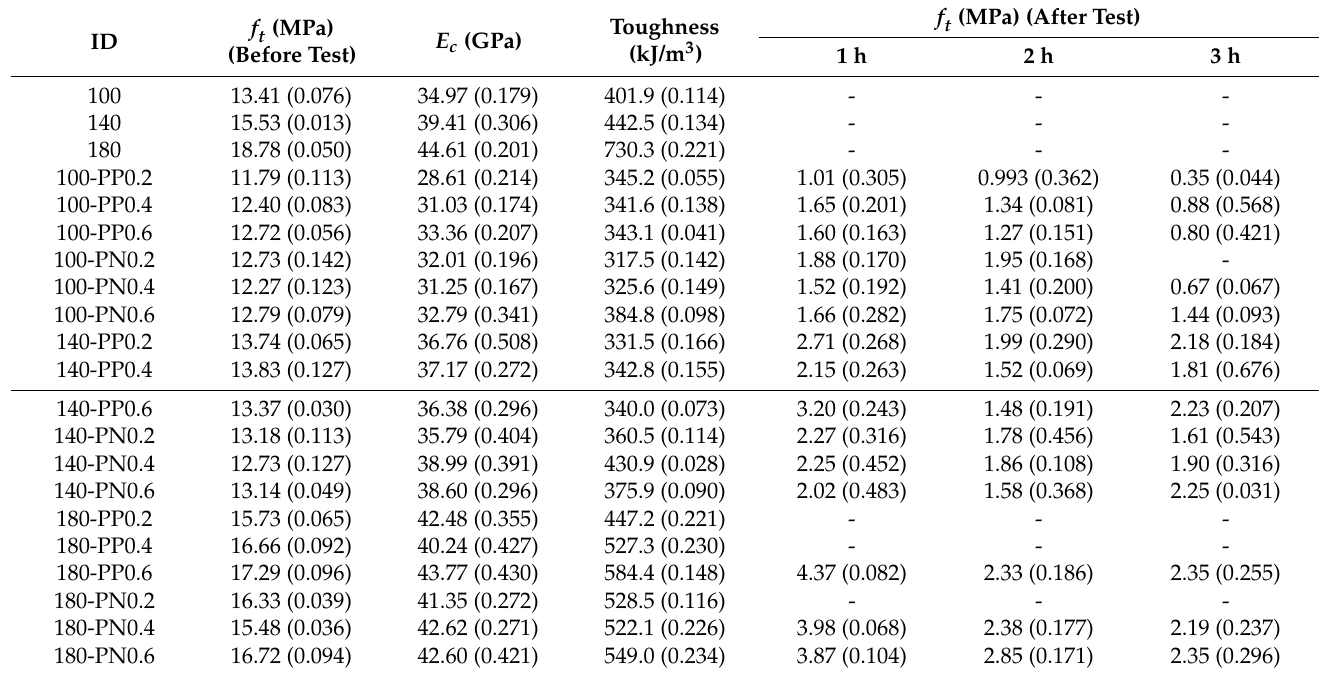
Table 5. Experimental results of the direct tensile strength before and after fire tests.